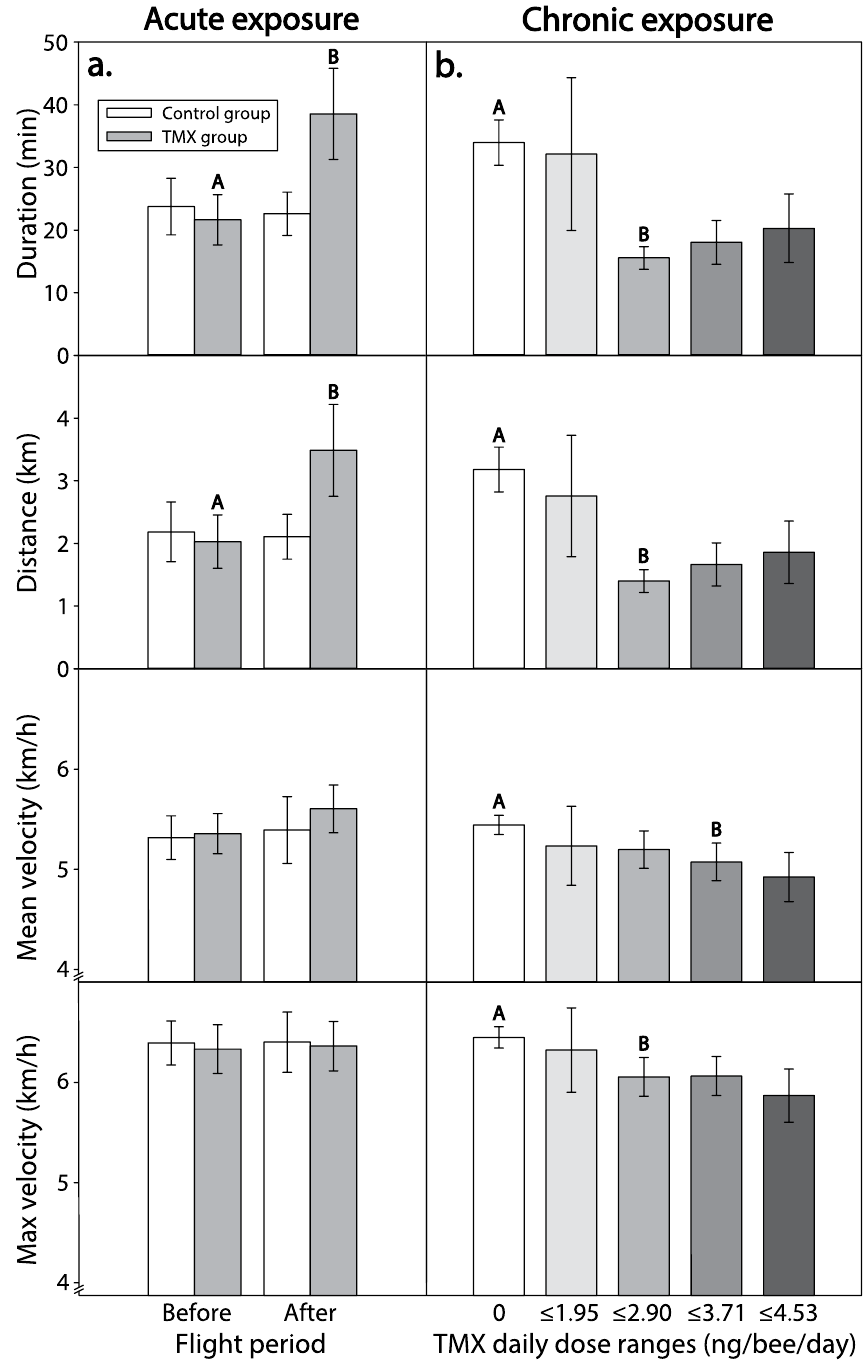
Figure 1. The effects of ( a ) acute or ( b ) chronic exposure to thiamethoxam (TMX) on forager flight ability. ( a ) In the acute experiment, we recorded flight duration, distance, mean velocity and maximum velocity before and after treatment; white bars are the control group ( ), grey bars are the TMX group ( ); the different letters indicate significant differences (LS Means contrast tests comparing before and after periods; N control group, before = 16, N control group, after = 16, N TMX group, before = 23, N TMX group, after = 23). ( b ) In the chronic experiment, we grouped the TMX daily doses ( N TMX daily doses = 46) in 5 TMX daily dose ranges (0, ≤ 1.95, ≤ 2.90, ≤ 3.71, ≤ 4.53 ng/bee/day). We pooled data from both days of exposure (1 or 2 days) because there was no significant effect of the number of days of exposure. Different shading reflects different daily dose ranges of TMX and different letters indicate significant differences (Least-Square Means contrast tests; N control = 94, N 32.5 ppb = 44, N 45 = 75). In the x-axis, we report the upper value of each bin range of TMX daily doses. Error bars show ppb standard